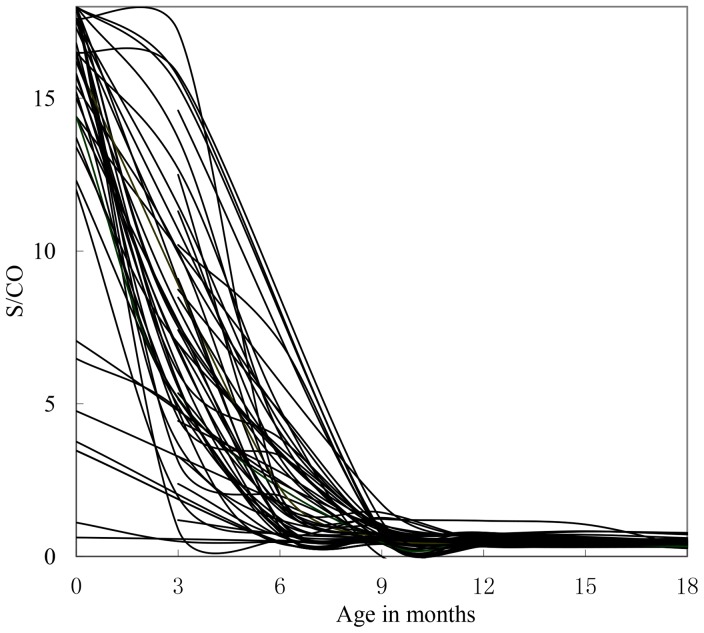
Anti-HIV S/CO values of uninfected infants at individual level.The arrow indicates S/CO = 1. The figure was derived from 312 DBSs of 56 uninfected infants whose HIV antibody S/CO values at the following months of age are available: 0 to 6, 6 to 9, 9 to 12, and 12 to 18.